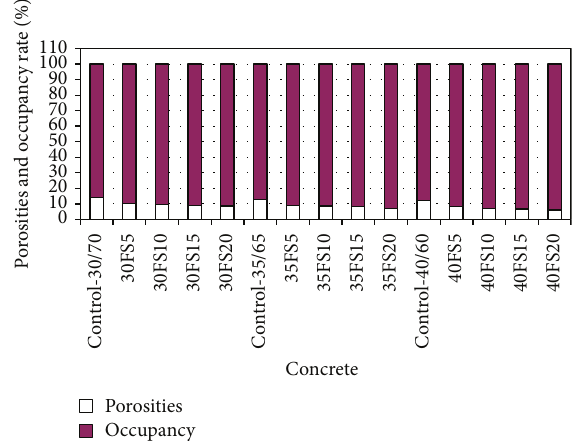
Figure 3: Porosity and occupancy ratios in